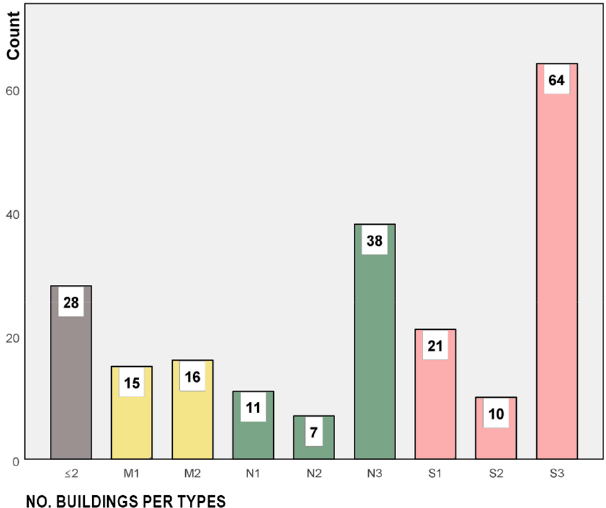
Figure 10. Numbers of sample buildings per type.